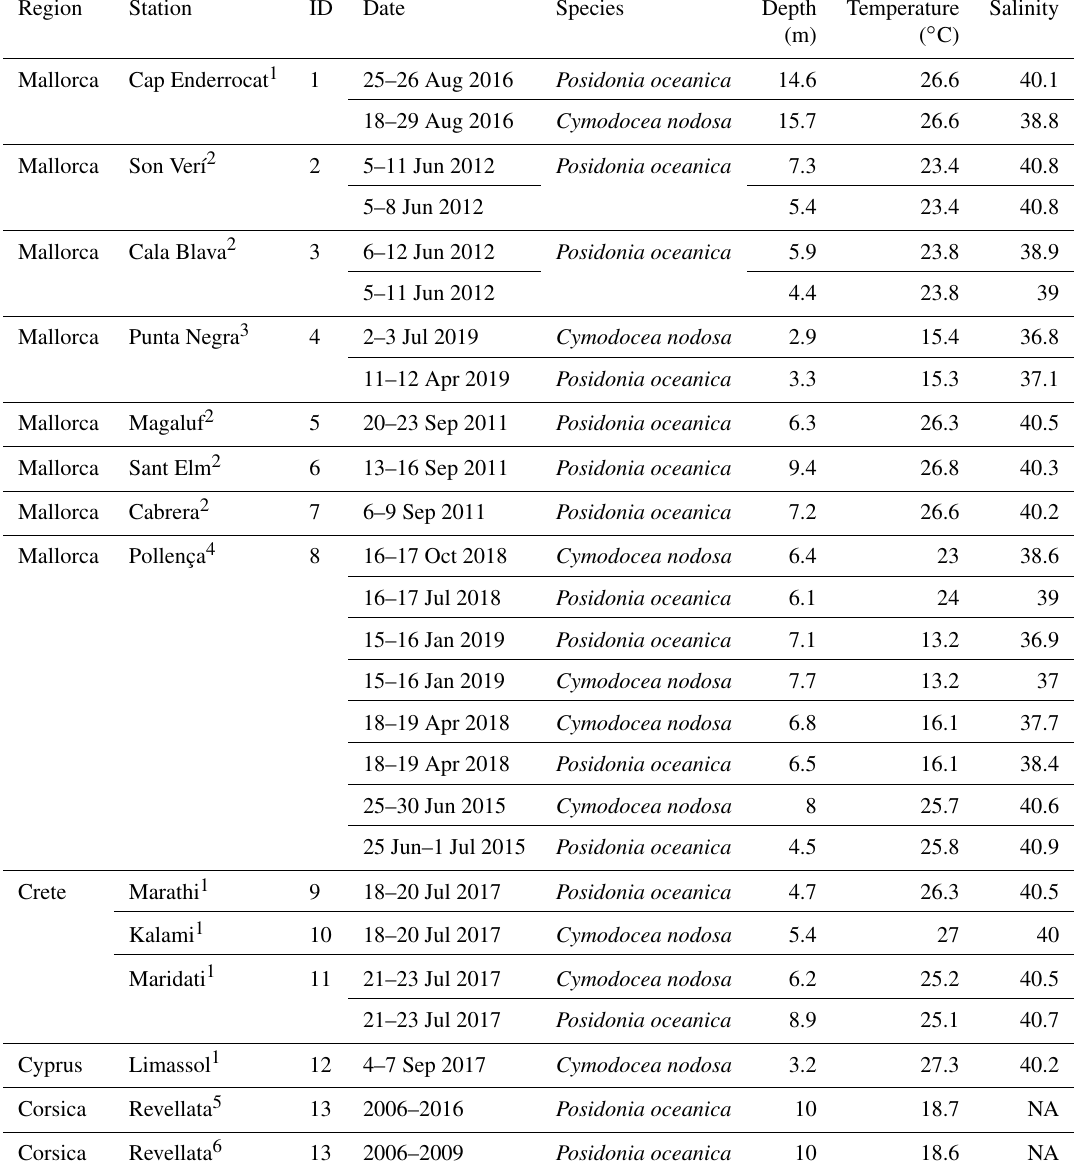
Table 1. Characteristics of sampling stations with data for multiparametric sensors. Temperature and salinity represent average values during the